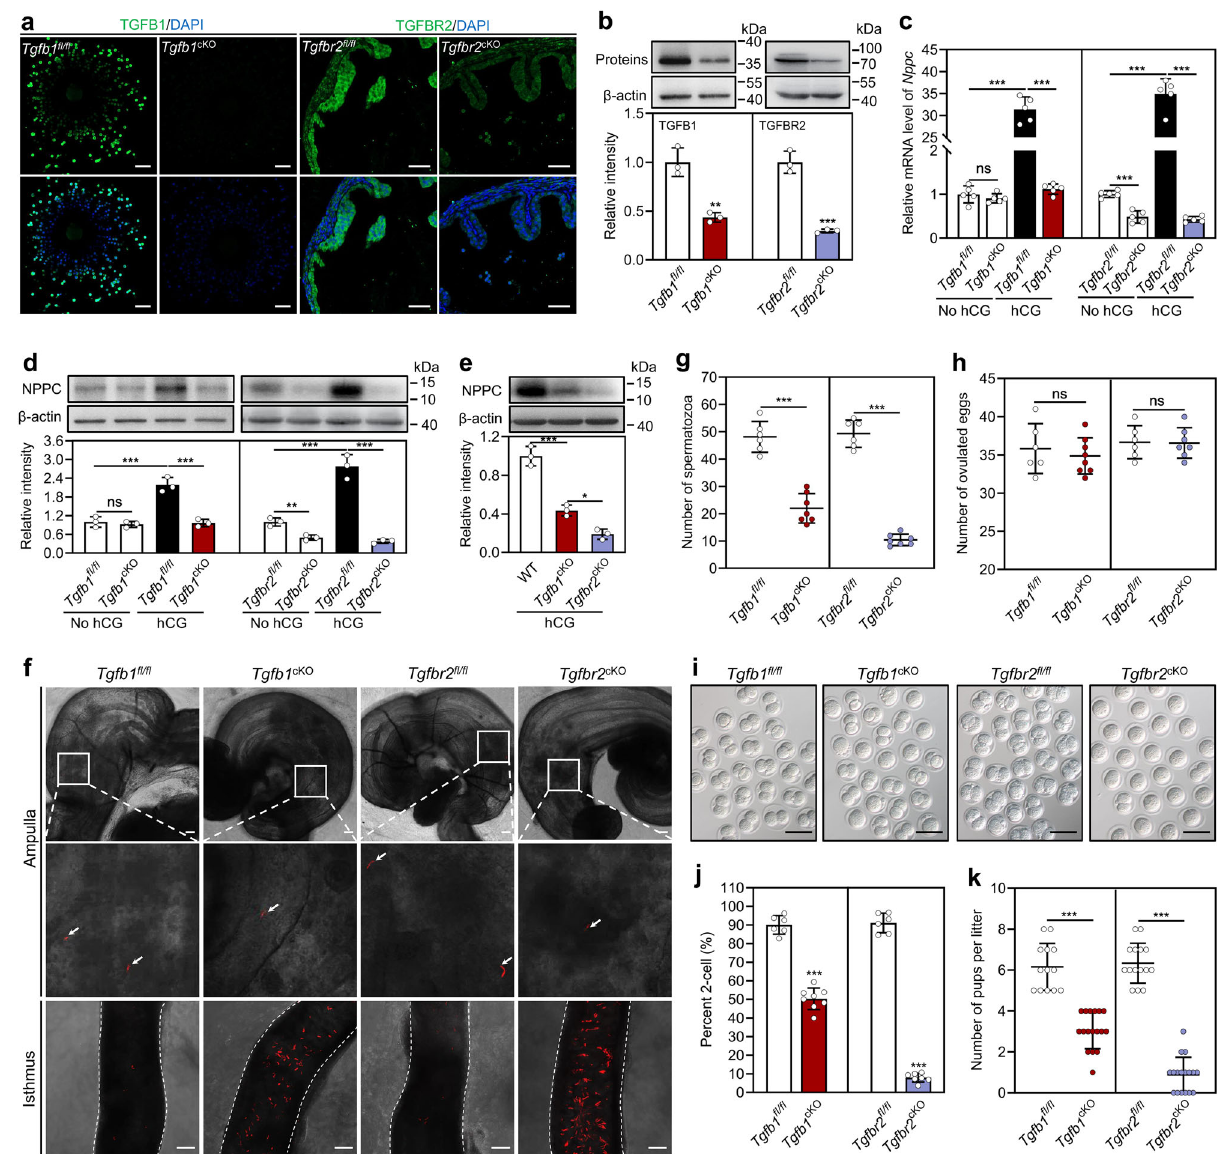
Fig. 4 Conditional deletion of Tgfb1 in cumulus cells and Tgfbr2 in ampullary epithelial cells blocks NPPC expression and sperm migration in the oviduct. a , b Knockout ef fi ciency of TGFB1 in cumulus cells and TGFBR2 in the oviductal ampullae were detected by immuno fl uorescence ( a ) and Western blotting ( b ). ( n = 3 mice in each group). OCCs and ampullae were isolated from superovulated mice at 13 h post-hCG treatment. Nuclei were counterstained by DAPI (blue). Scale bars represent 50 μ m. c , d NPPC mRNA ( c ) and protein ( d ) levels in the ampullae isolated from mice before and after hCG injection (at 13 h post-hCG treatment). ( n = 5 independent experiments in ( c ) and n = 3 independent experiments in ( d )). e NPPC protein levels in the ampullae isolated from superovulated mice at 13 h post-hCG treatment ( n = 3 independent experiments). f Representative images of the oviductal ampulla and lower isthmus isolated from mice ~3 h postcopulation (at 16 h post-hCG treatment). ( n = 6-7 mice in each group). The dashed line represents the edge of the oviductal lower isthmus. Ampli fi ed views of the boxed area are shown in the lower pane. Arrow indicates spermatozoon in the oviductal ampulla. Scale bars represent 100 μ m. g The number of spermatozoa in the ampullae. Oviducts were isolated from mice ~3 h postcopulation (at 16 h post-hCG treatment), and the number of spermatozoa in the ampullae were counted for each mouse. ( n = 6 – 7 mice in each group). h Number of oocytes ovulated by Tgfb1 fl / fl , Tgfb1 cKO , Tgfbr2 fl / fl , and Tgfbr2 cKO mice ( n = 6 – 8 mice in each group). i Representative images of the two-cell embryos. Scale bars represent 100 μ m. j , k Rate of two-cell embryos ( j ) and the number of pups per litter ( k ). ( n = 6 – 17 mice in each group). Two-cell embryos were obtained from